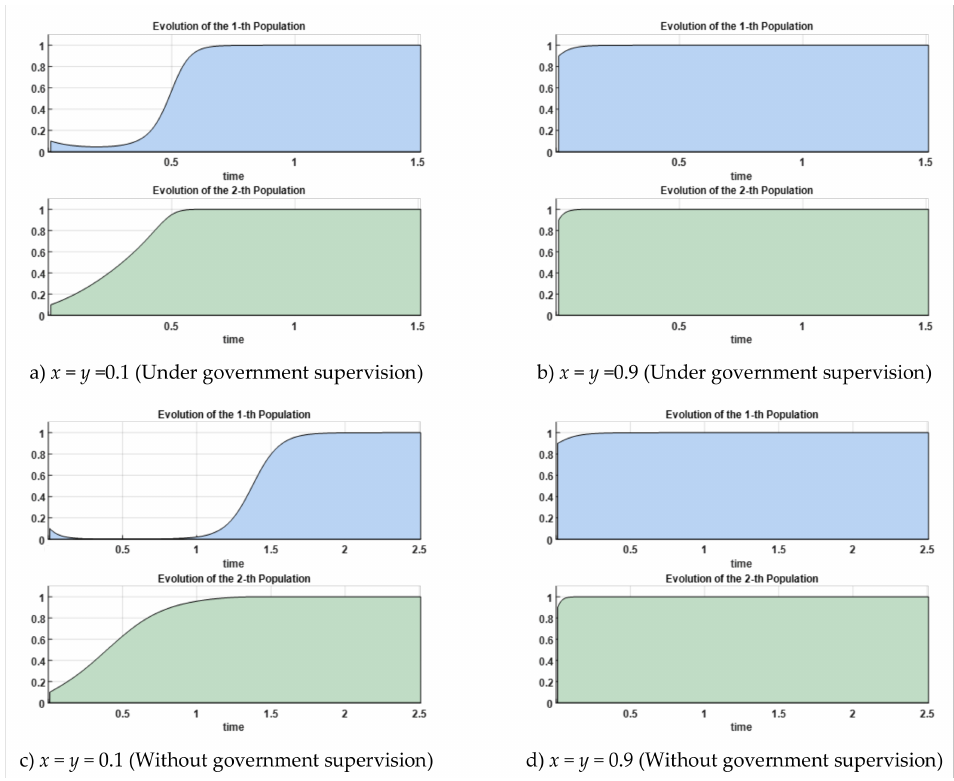
Figure 10. Influence of initial probability change on system